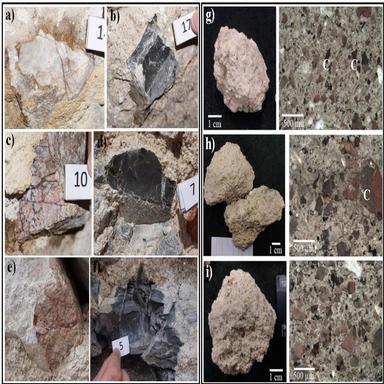
Constituent materials of NPS masonry walls: stone blocks of the most representative lithotypes (a-f) and mortars (g-i) (C: ceramic fragments).